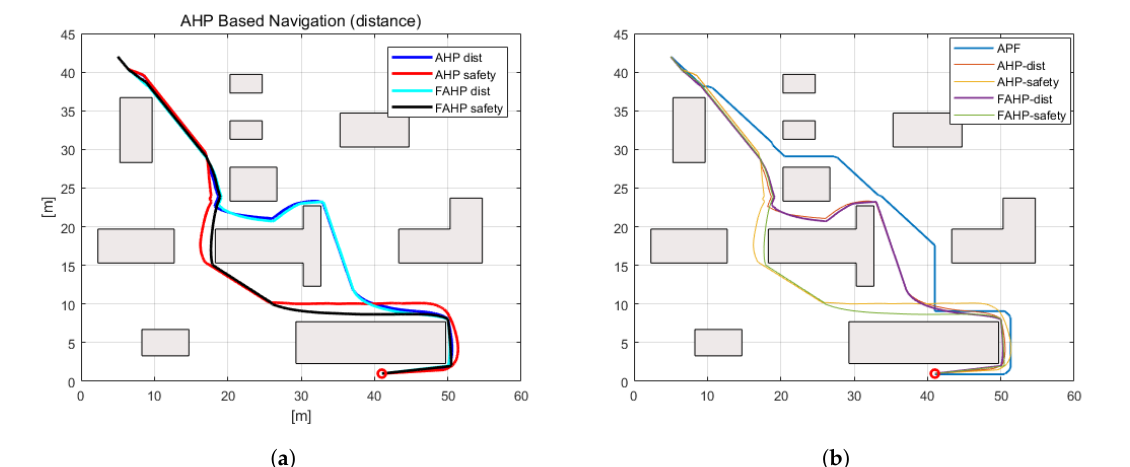
Figure 14. Navigation results: ( a ) Navigation path comparison between AHP and FAHP ( b ) Navigation path comparison among all